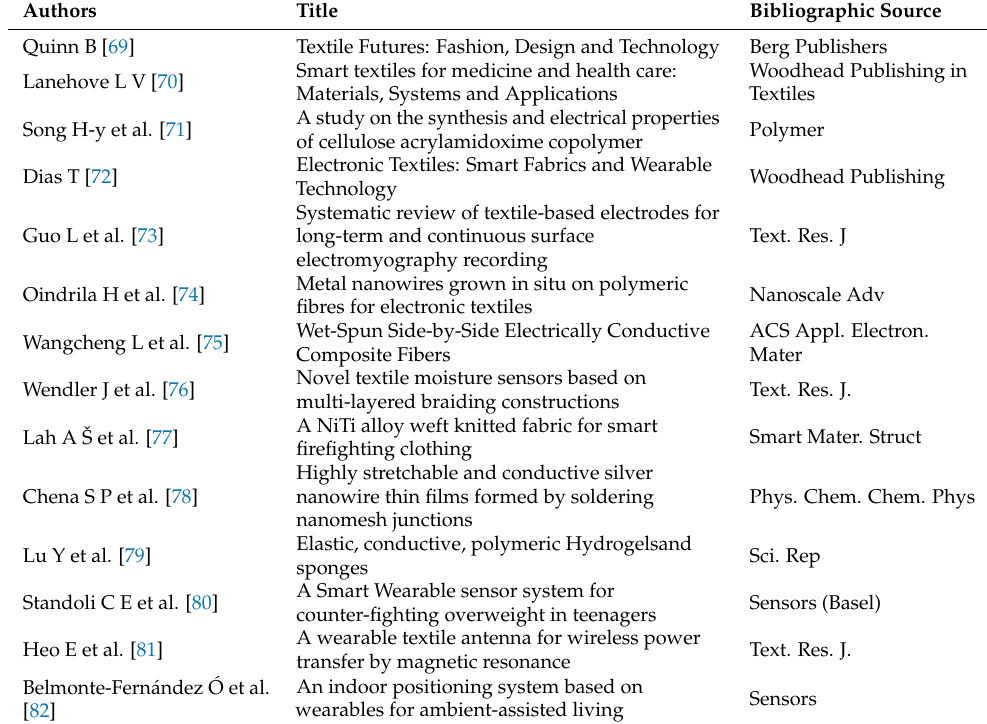
Table 5. Systematization/enumeration of conductive materials papers with bibliographic